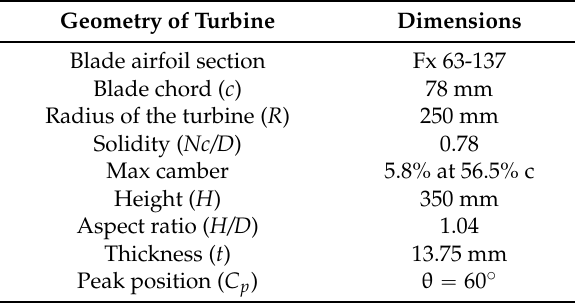
Table 1. Properties of the wind turbine.